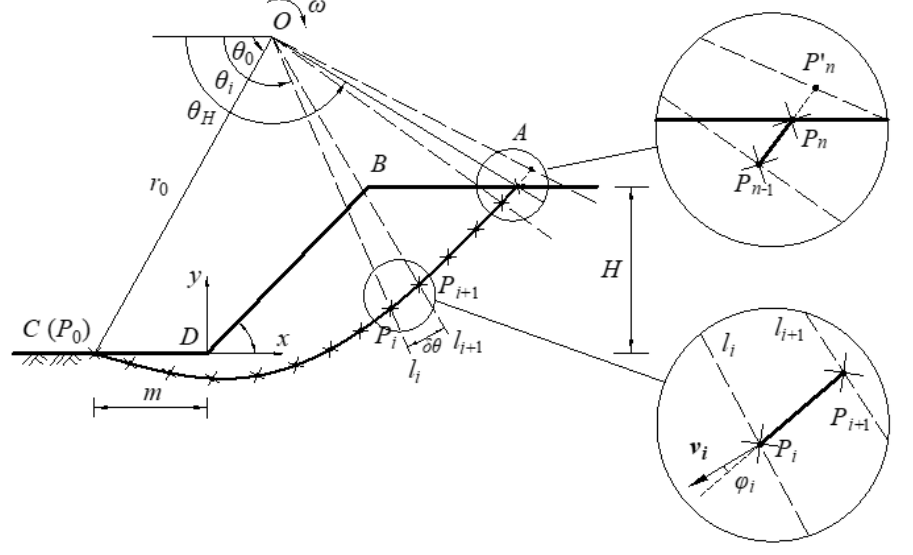
Figure 2. Principle of the discretized failure mechanism of DKA.